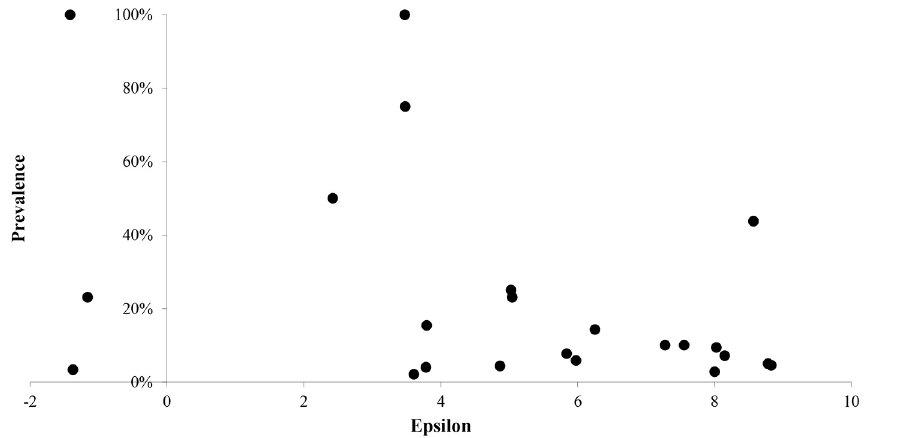
Fig 4. Graph of prevalence versus epsilon by